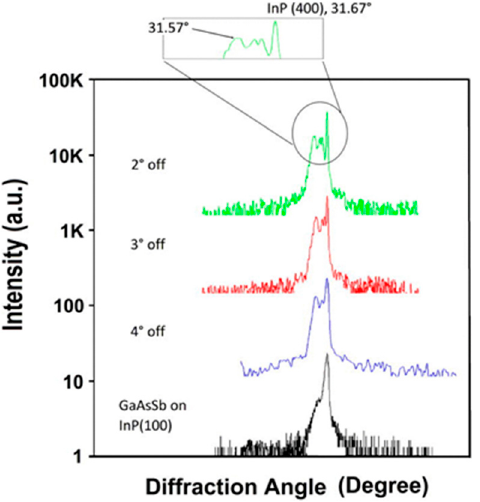
Figure 3. X - ray diffraction (XRD) of 1 µm-thick GaAsSb epi-grown layers on InP (100) and 2°, 3° and 4° off-axis InP (100) substrates. Reproduced with permission from [21], copyright AIP Publishing LLC (2013). Table 1. Growth conditions of the GaAsSb alloy samples. Reproduced with permission from [22], copyright Nature Publishing Group (2016).